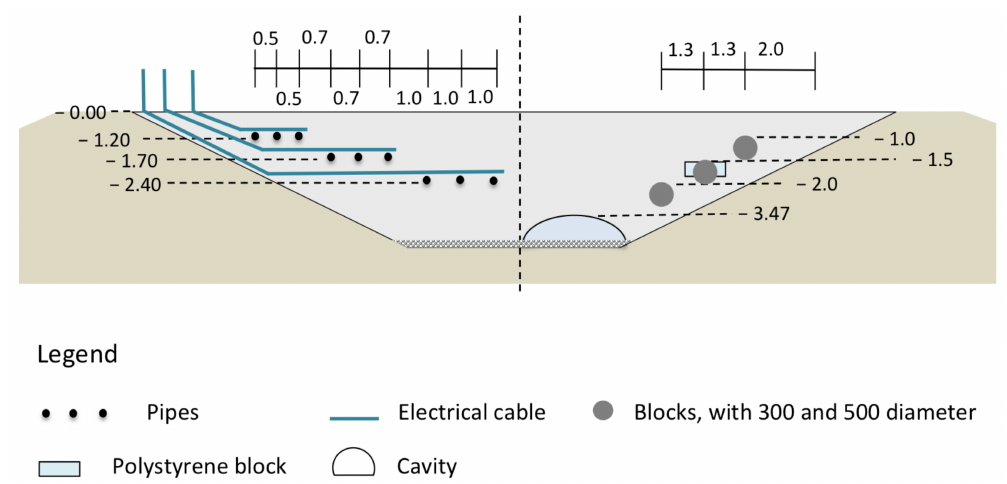
Figure 9. Transversal section of the limestone region, showing the embedded targets and their positions. All distances are expressed in meters.